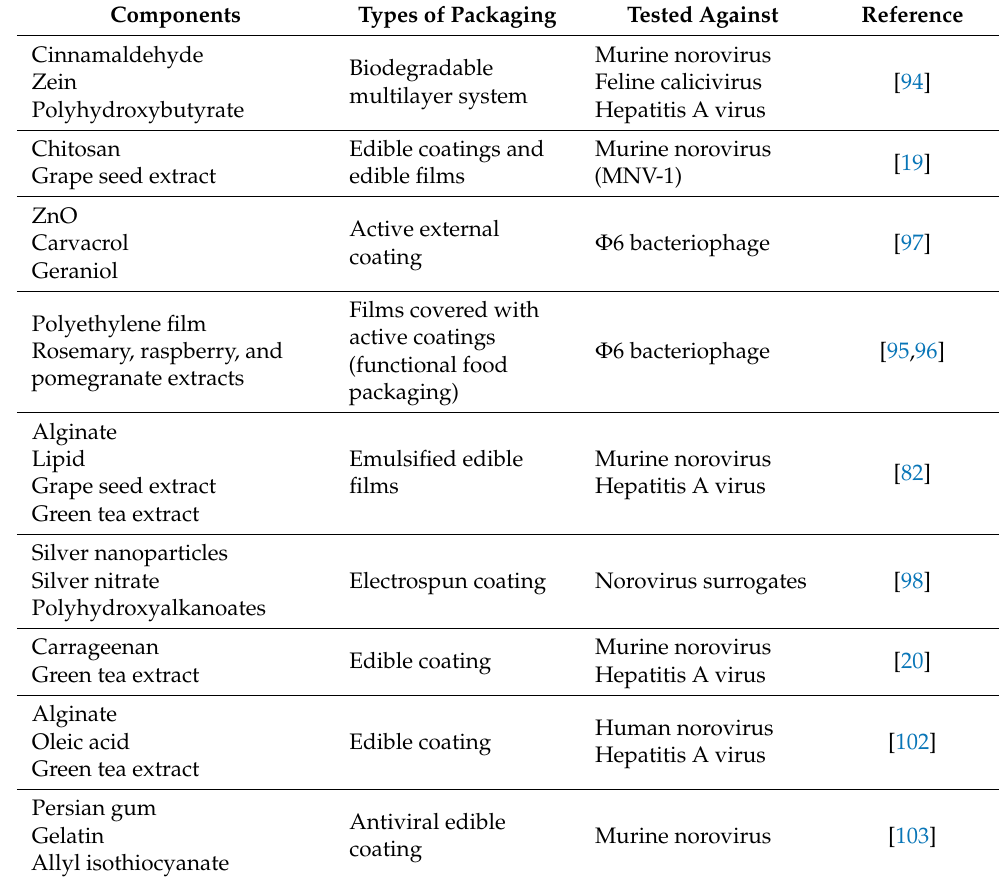
Table 2. Antiviral active packaging system for food products. Components Types of